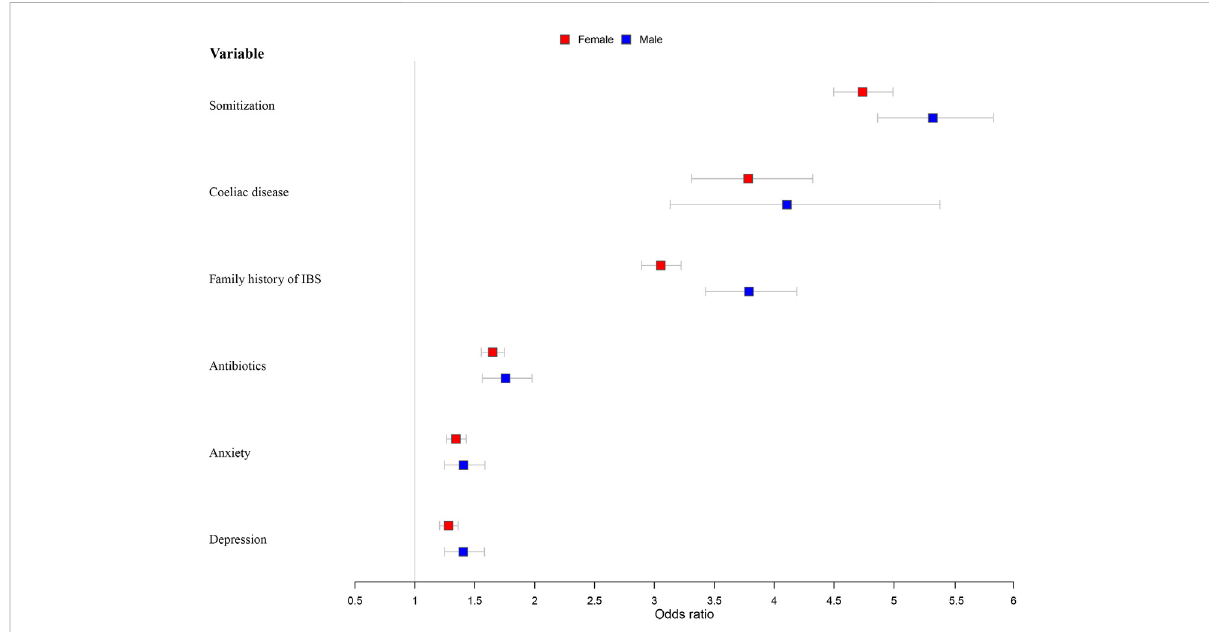
FIGURE 4 Models of factors associated with IBS strati fi ed by sex and adjusted for age and socioeconomic